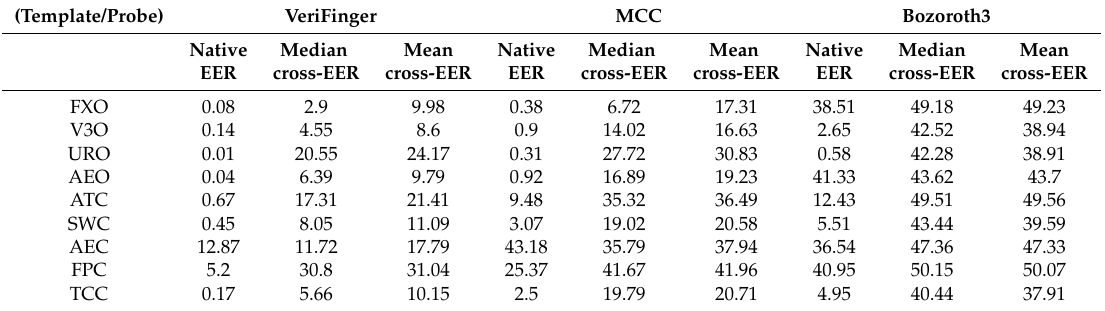
Table 7. Native EER, median, and mean cross-device EER values produced by the tested systems. (Template/Probe)